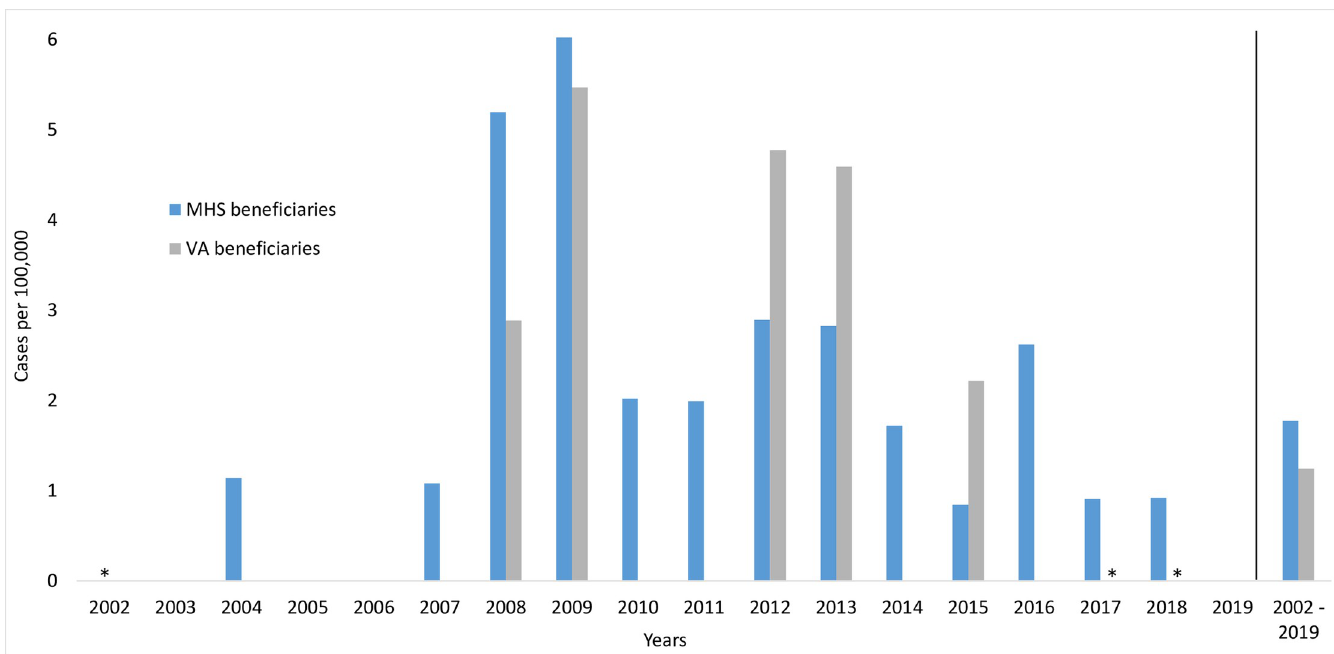
Fig 1. Annual and cumulative incidence rates of MTB among Military Health System (MHS) and Veterans Affairs (VA) beneficiaries in Hawaii and Pacific Islands, 2002–2019. � No data available for 2002 for MHS beneficiary population; no data available for 2017, 2018 for VA beneficiary population.